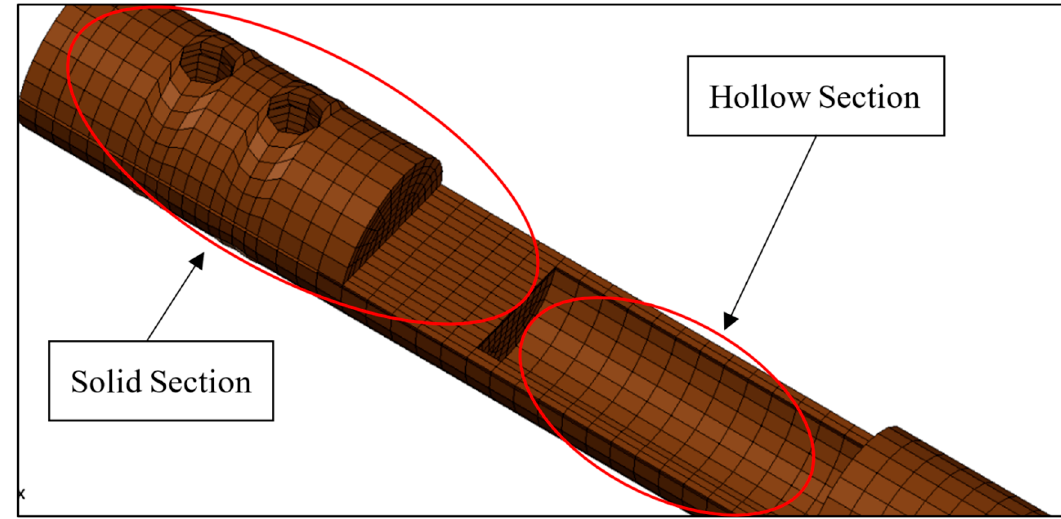
Figure 4. Cutaway of the front tip of the transmitter bar that illustrates the solid section and the hollow section of the transmitter bar. Table 2. Dimension of each SHTB component with the corresponding simulated